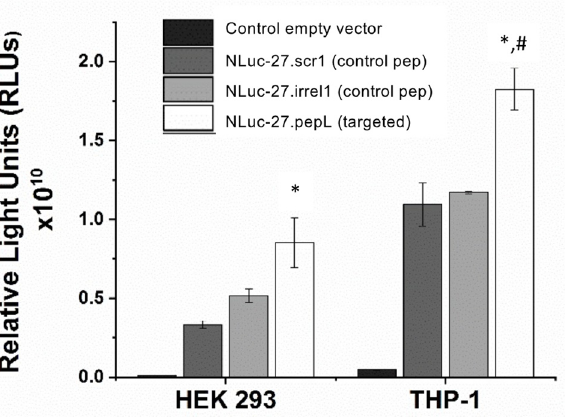
Figure 6. Validation of ligand-targeting efficacy in ‘sensor cells’ displaying differential expression of the target cytokine receptor, IL-6R α . Targeted Nluc-27pepL displayed a signal significantly higher than controls when incubated with HEK293. This ligand binding (homing) was enhanced in THP-1 cells which presented significantly more IL-6R α on the cell surface. Data are presented as mean ± SEM. Comparisons within cell types were performed using one-way ANOVA. A p -value < 0.05 indicates a significant difference (*). Comparisons between cell types were performed using unpaired t -test. A p -value < 0.05 indicates a significant difference (#).